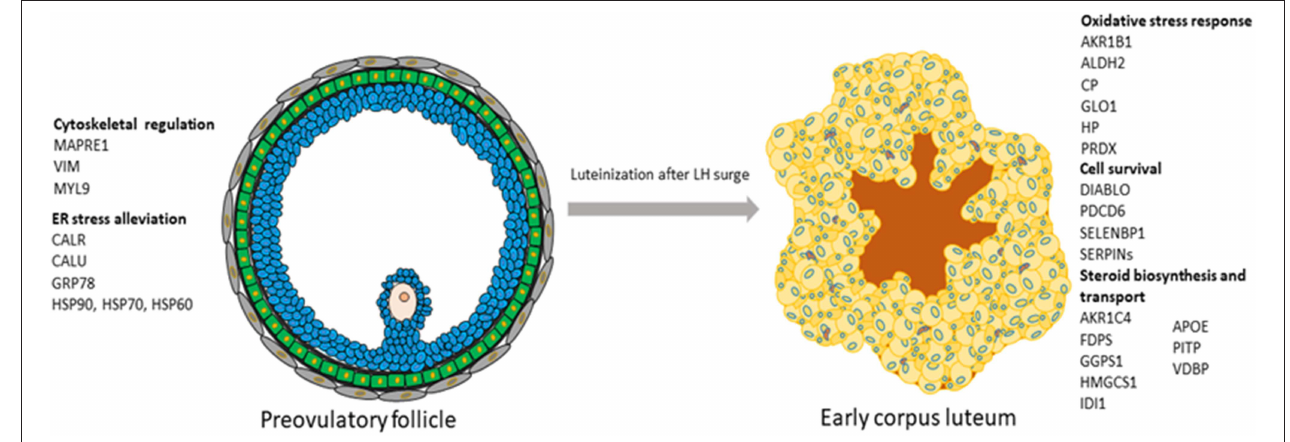
FIGURE 6 | Schematic representation of the processes and their associated proteins that were highly represented either in preovulatory follicles or in early corpus